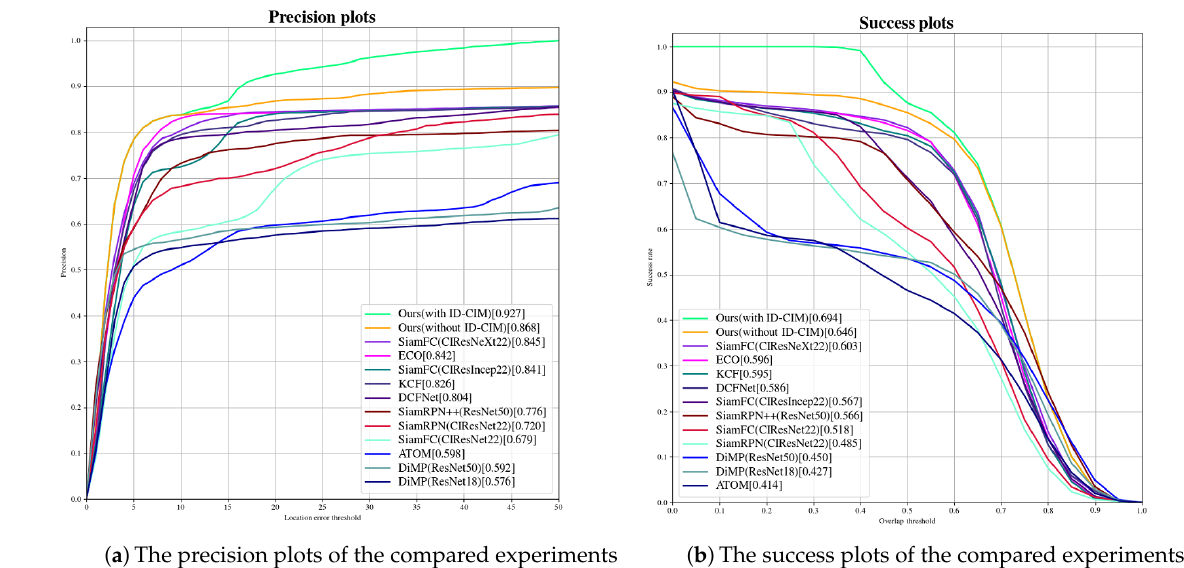
Figure 8. The precision plots and success plots of the compared experiments with the state-of-the-art trackers.